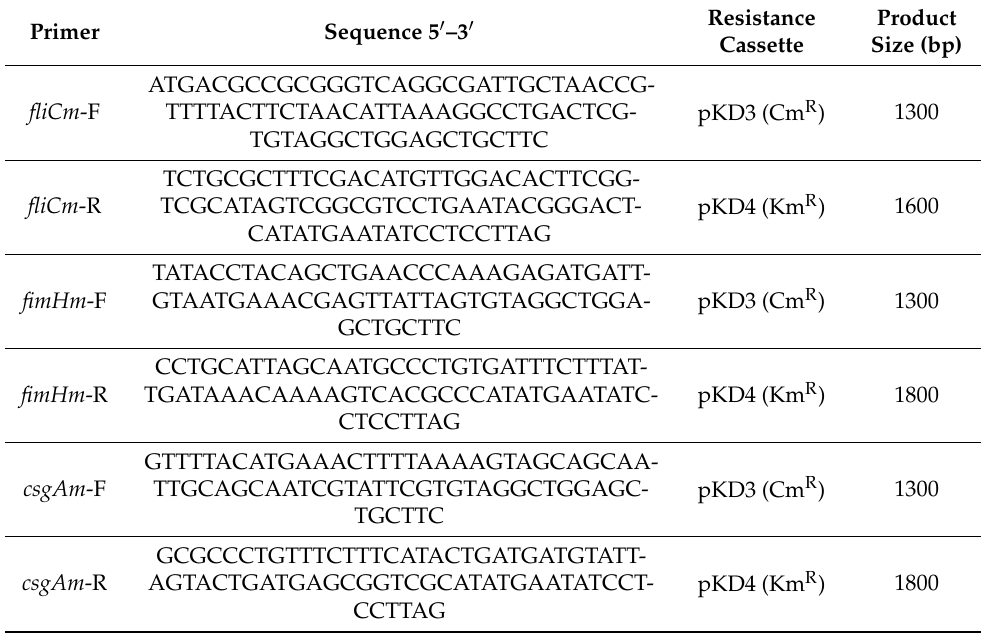
Table 2. Primers used for inactivation of the fliC , fimH, and csgA genes in UPEC strain CFT073. Primer